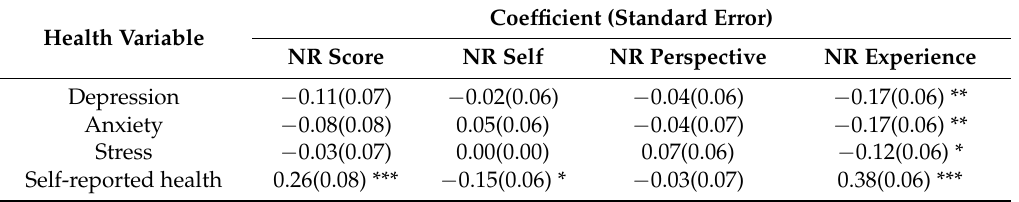
Table 2. Relationships between Nature Relatedness and Four Health Variables (From Ordinal Regression Models, Cumulative Link), Without Accounting for Covariates (Zero Order Correlations).